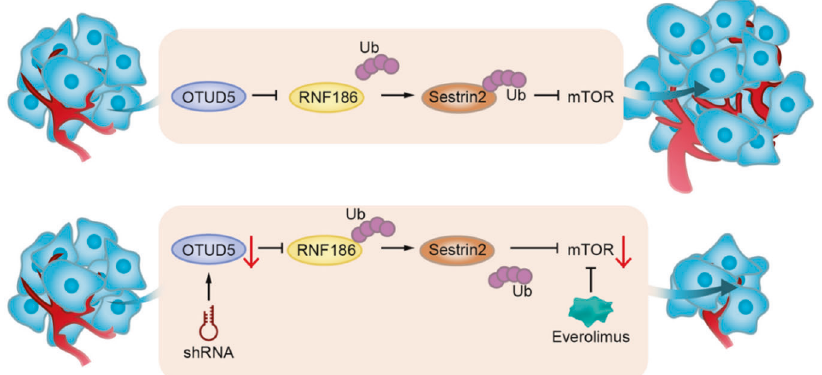
Fig. 7 Schematic models. Upper: OTUD5 exerts its functions through the OTUD5-RNF186-sestrin2-mTOR axis to promote bladder cancer proliferation. Bottom: Downregulation of OTUD5 and everolimus show inhibitory effects on bladder cancer growth.